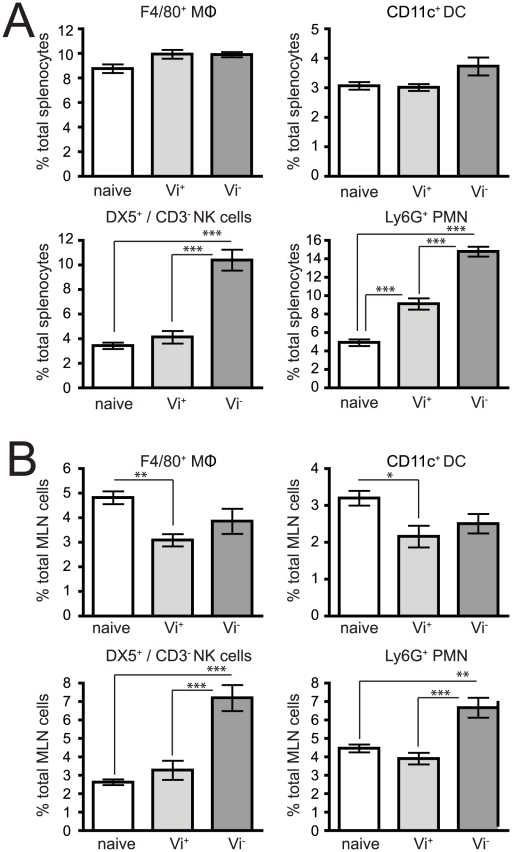
Expression of the Vi capsule induces differential innate immune responses shortly after infection.Cells were isolated from the spleens after i.v. infection (A) or MLN after oral infection (B) of C57BL/6 mice 24 h after infection with C5507 (Vi+) or SGB1 (Vi−) S. Typhimurium and stained with flurochrome-labelled mAb and analysed by flow cytometry in which 20,000–200,000 events were recorded. Columns represent the percentage ± SEM. Significant differences in values of * p<0.05; **, p<0.01; ***, p<0.001, as determined by one-way ANOVA followed by Bonferroni's multiple comparison test.